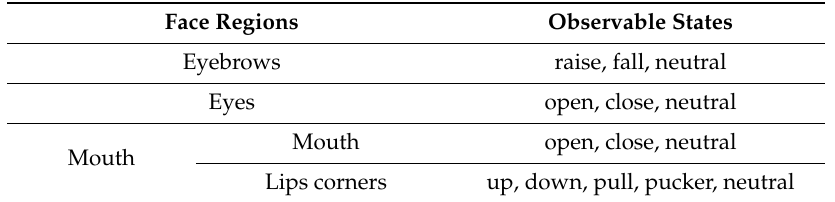
Table 1. States of three face